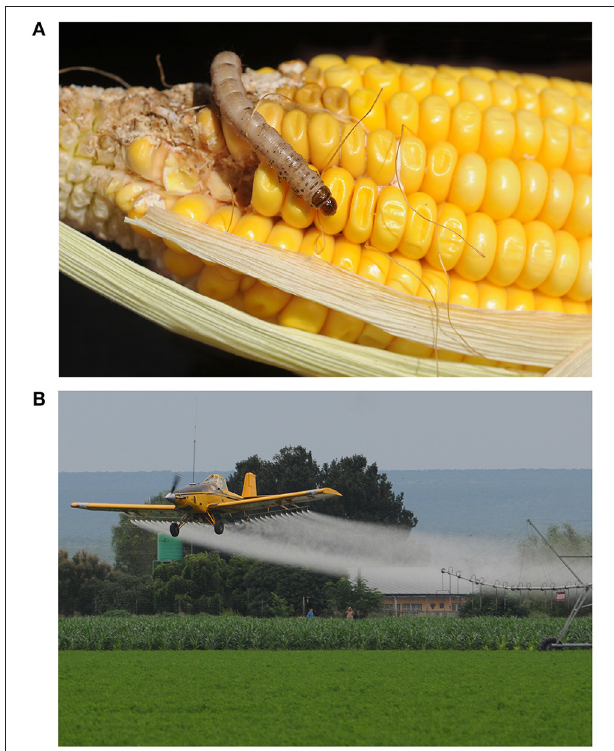
FIGURE 1 | Resistance development to Cry1Ab in South Africa. After the development of resistance to Bt, the larvae of the target pest, Busseola fusca , could be observed in the field, feeding on MON810 maize cobs (A) . The response from the farmers was to spray insecticides, paid by Monsanto, on the “insect resistant” MON810 Bt-maize plants to reduce yield losses (B) . Photos taken in the Vaalharts region in 2012 by Thomas